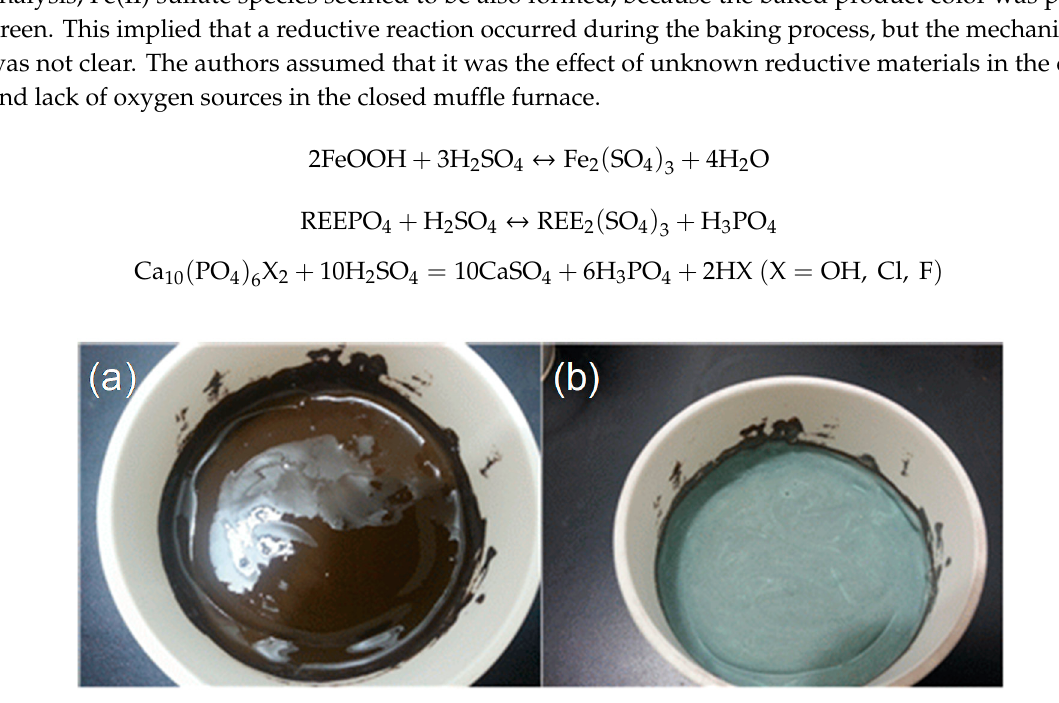
Figure 9. XRD patterns before and after sulfuric acid baking at different acid/solid ratios: ( a ) raw ore; ( b ) acid/solid ratio = 1.0; ( c ) acid/solid ratio = 2.0. In the succeeding water-leaching step, the REE recovery was significantly improved as shown in Figure 10, as the maximum levels were Ce 98.4%, La 99.1%, Nd100% and Y 96.5% after baking at an acid/solid ratio of 2.0. The sulfuric acid concentration in the leaching step was calculated simply from the amount added for the baking step. The corresponding sulfuric acid concentrations in leaching solutions with acid/solid ratios of 0.5, 1.0 and 2.0 were 0.57, 1.13 and 2.27 M, respectively, although some part of the acid was consumed during the baking step. In the preliminary leaching results, when 0.5, 1.0 and 2.0 M of nitric acid were used, the REE-leaching efficiency was significantly less than that of the baked sample. Thus, it can be concluded that the sulfuric acid baking effectively decomposed the minerals in the ore. In terms of impurity-leaching, the Fe and P recoveries were considerably increased to 38.0% and 30.3%, 65.9% and 60.6% and 81.1% and 87.5% after baking at 0.5, 1.0 and 2.0 acid/solid ratios, respectively, compared with the maximum Fe and P recoveries of 20.0% and 41.2%, respectively, at 3.0 M nitric acid and 80 °C. This also implied that the minerals were effectively decomposed via the acid baking process. In addition, the Fe recovery was much higher in this study than in the previous one [24], which was approximately 20% at 1.5 acid/ore ratio. This was because the Fe(II) species formed in the current study were more soluble, whereas in the previous study, only less soluble Fe(III) species were present even after sulfuric acid baking. In contrast, the Ca acted in a different manner from other metals. Its recovery remained at the same level of 57–58% regardless of the acid/solid ratio. This level was 1.62–1.65 times less than the recovery of the preliminary leaching results of 94.1% at 3.0 M nitric acid and 80 °C. Interestingly, the